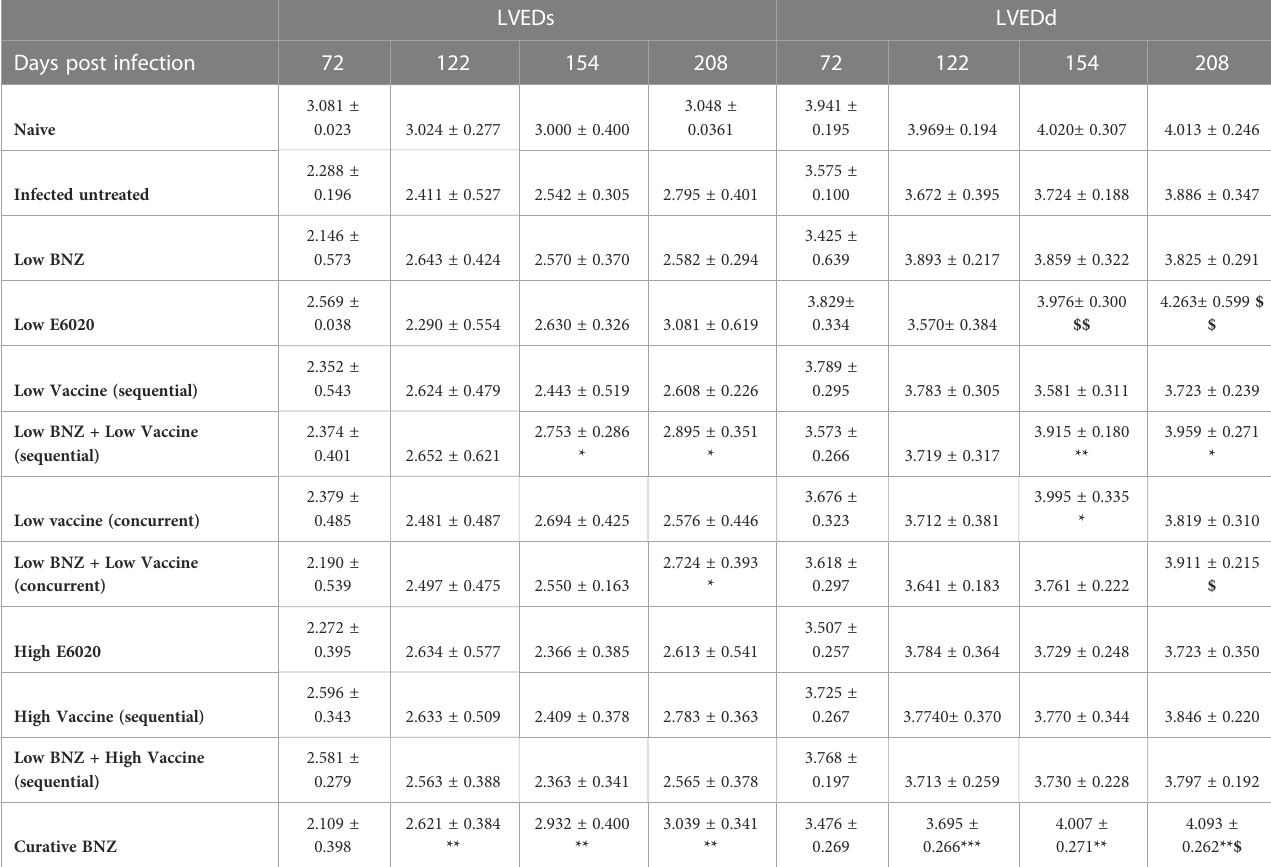
TABLE 2 Left ventricular end diameter during systole and diastole.